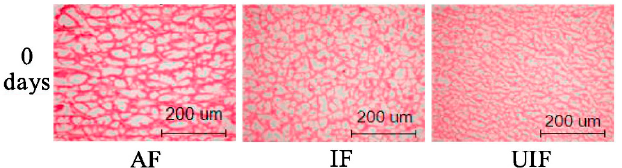
Figure 2. Microstructure changes of frozen carp under air freezing (AF), immersion freezing (IF), and ultrasound immersion freezing (UIF) during freezing. Where white is the hole left by ice crystals and pink corresponds to muscle fiber [86] .